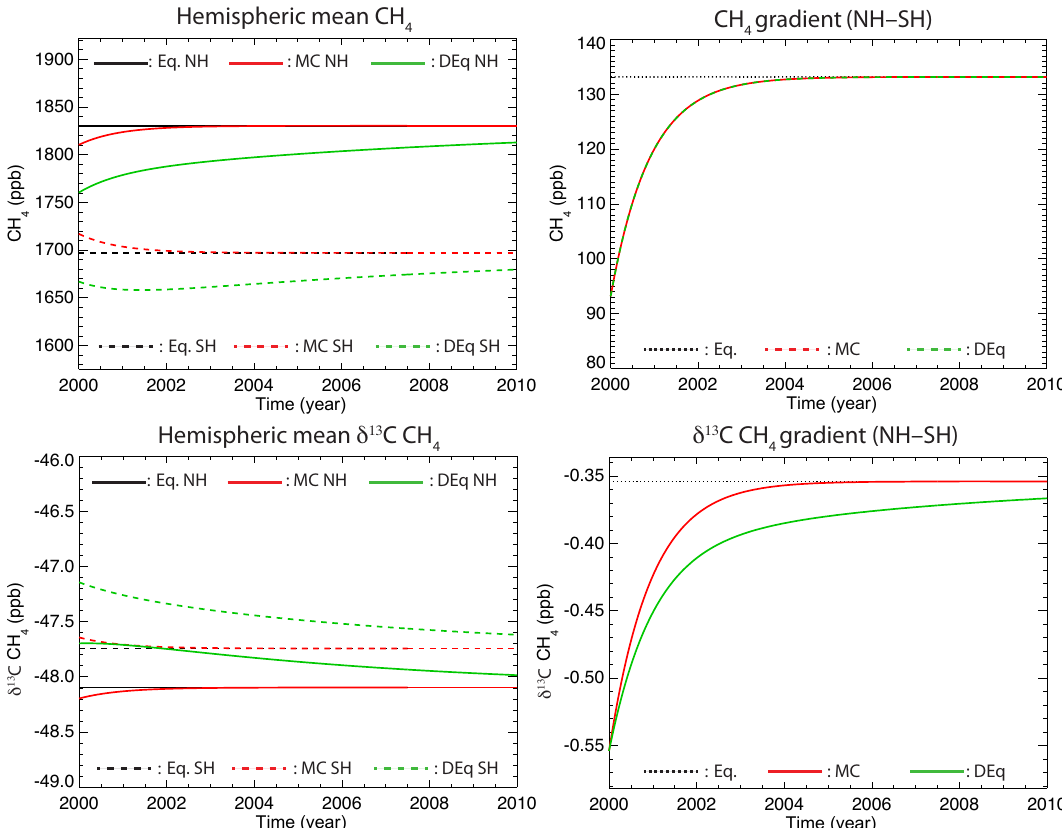
Figure 2. Box-model-calculated relaxation times to hemispheric disturbances in CH 4 and 13 CH 4 with respect to a steady-state equilibrium (“Eq”). Theoretical disturbances of the steady state are either global mass conserved (“MC”) or not